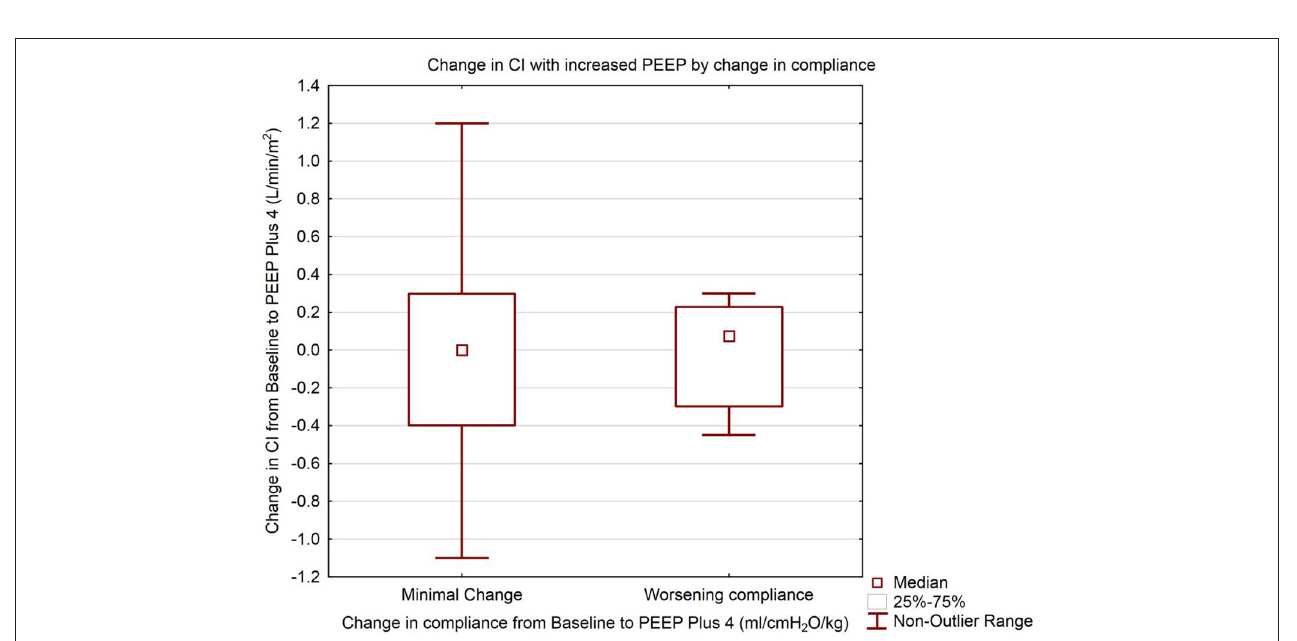
FIGURE 2 | Change in Cardiac Index with increased PEEP. Groups separated by change in dynamic compliance of the respiratory system. Data are presented as median, inter-quartile, and non-outlier range. The left box represents change in cardiac index from Baseline to PEEP plus 4 cmH 2 O where there was minimal or no change in the respiratory compliance from Baseline to PEEP plus 4 cmH 2 O. The right box represents the change in cardiac index for subjects where the respiratory compliance worsened from Baseline to PEEP plus 4 cmH 2 O. There is no statistically significant difference between the change in cardiac index between the two groups (Mann Whitney U test, p =